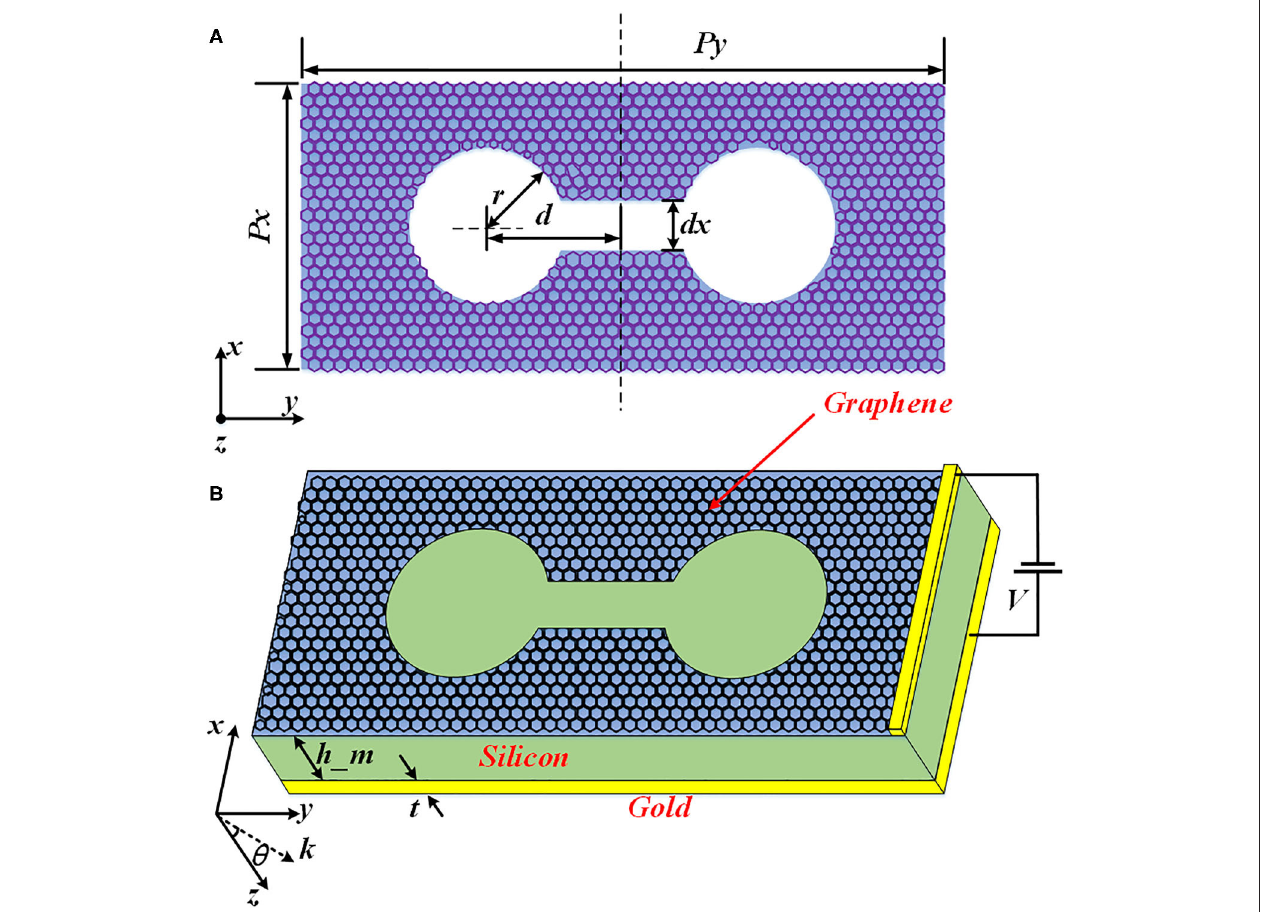
FIGURE 1 | (A) Structure of the dumbbell-shaped graphene layer; (B) Schematic of the designed terahertz perfect absorber, including a top layer of continuous graphene metasurface, a middle layer of the silicon dielectric layer, and a metal gold plate. Geometry parameters here: Px = 200 µ m, Py = 450 µ m, r = 55 µ m, d = 95 µ m, dx = 35 µ m, h_m = 50 µ m, and t = 0.2 µ